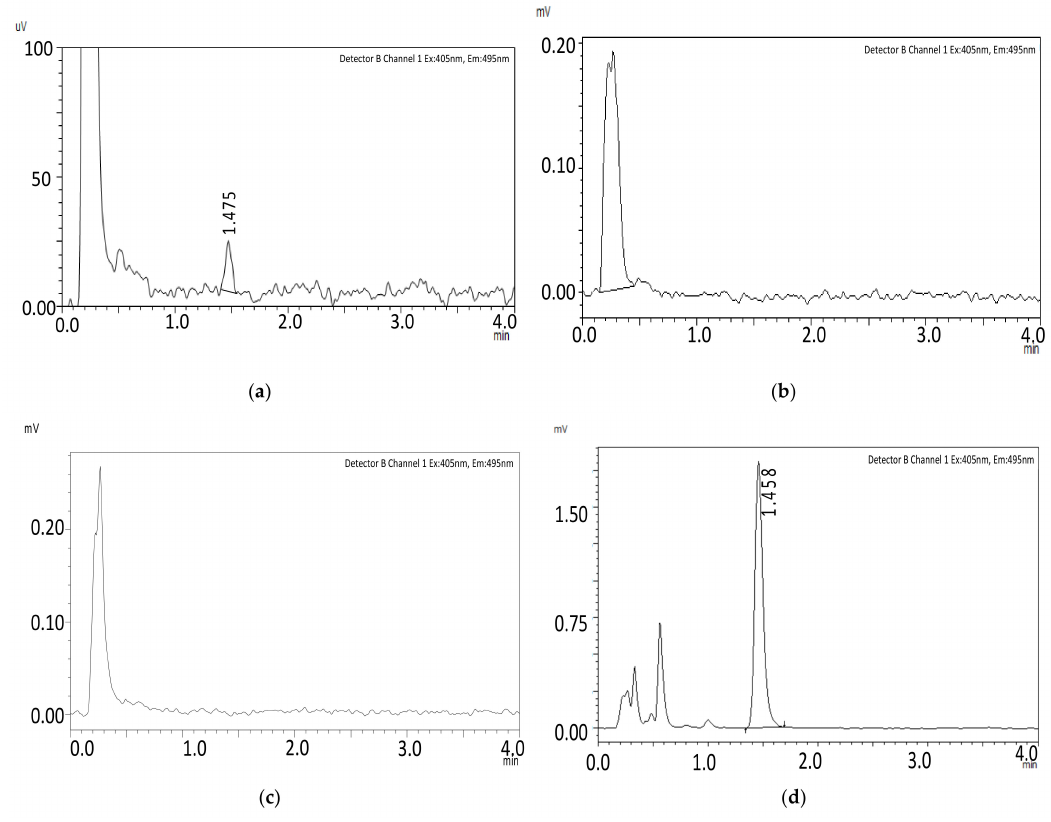
Figure 2. ( a ) Capmatinib absorption spectrum; ( b ) naproxen (internal standard) absorption spectrum. Spectra were obtained by the photodiode array detection at the corresponding retention times of capmatinib (3.7 min) and naproxen (8.9 min) following injection of individual standard solutions (1.3 and 1.0 mg/mL, respectively) on the HPLC-PDA system.